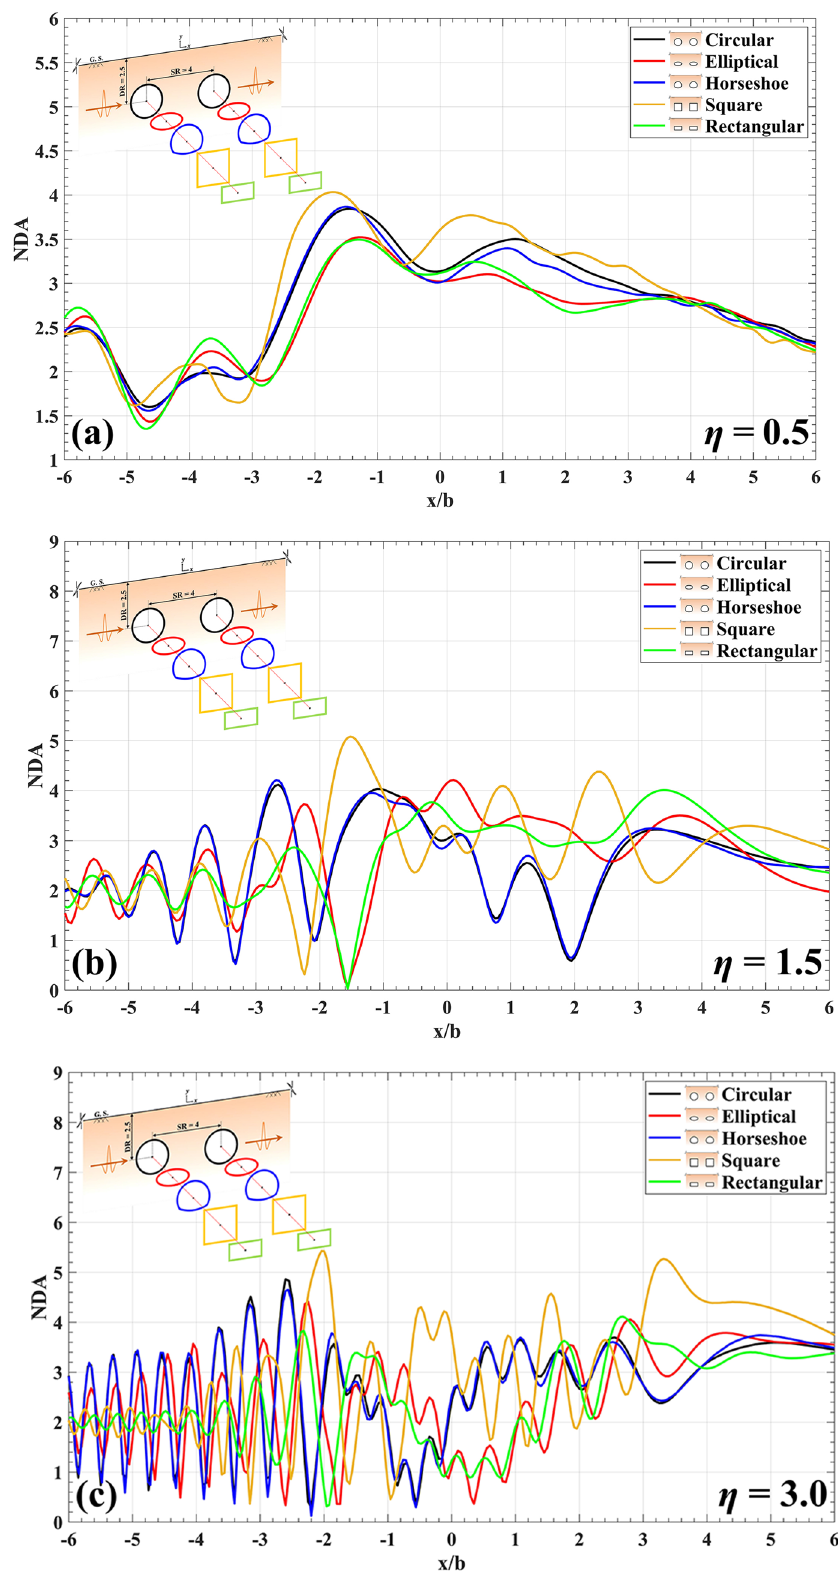
Fig. 12 The normalized dis- placement amplitude of the ground surface versus x ∕ b , for the model of twin lined tun- nels with different geometries and dimensionless frequency of a 𝜂 = 0.5 , b 𝜂 = 1.5 and c 𝜂 = 3.0 subjected to the hori- zontal incident SH